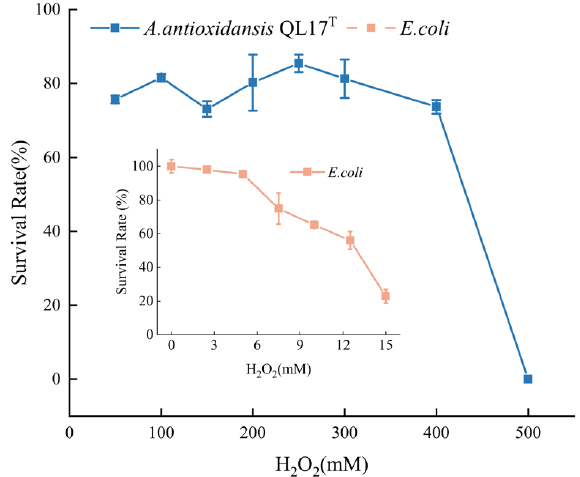
Figure 2. Survival rate of QL17 and E. coli stressed by the H 2 O 2 . Error bars represent standard deviation of the mean ( n = 3); p < 0.05.